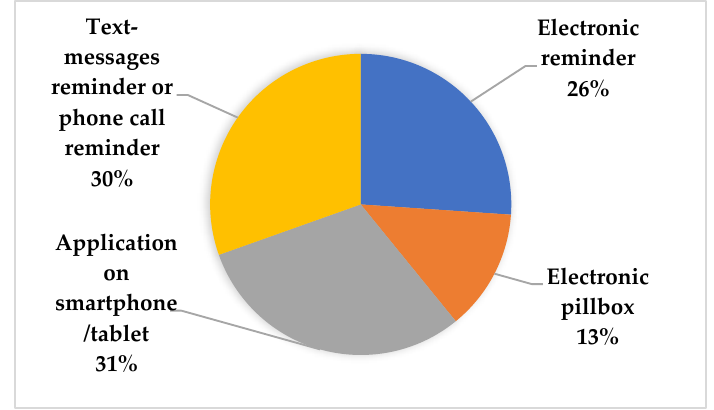
Figure 5. Technology-mediated strategies of the included studies.